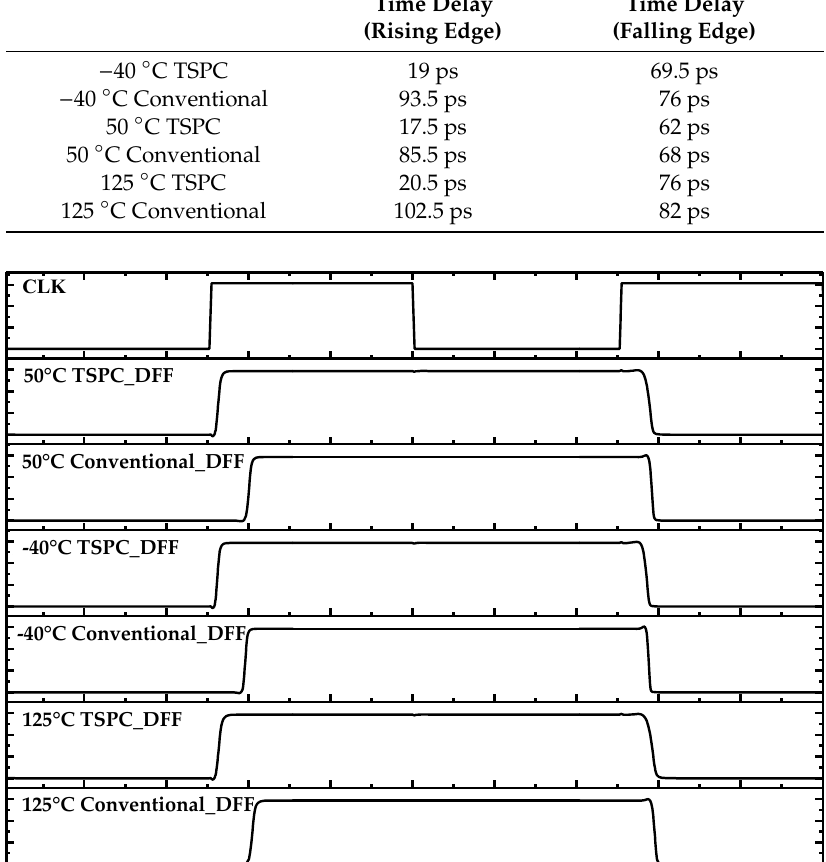
Figure 8. Simulation result and comparison of time delay between the conventional structure (transmission-gate based) and TSPC DFF. Table 1. Time delay of the two structure of the DFF.